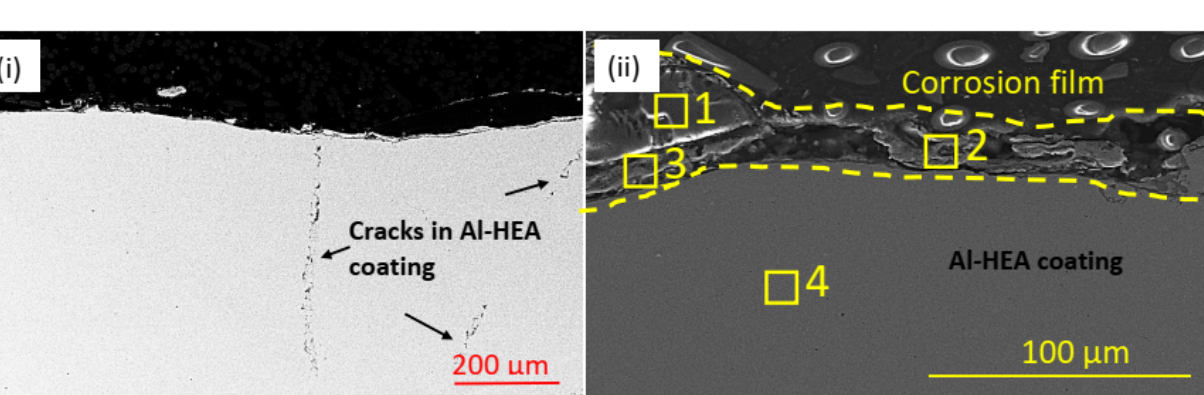
Figure 7. Elemental mapping of the boundary between Al-HEA coating and the 304L substrate.